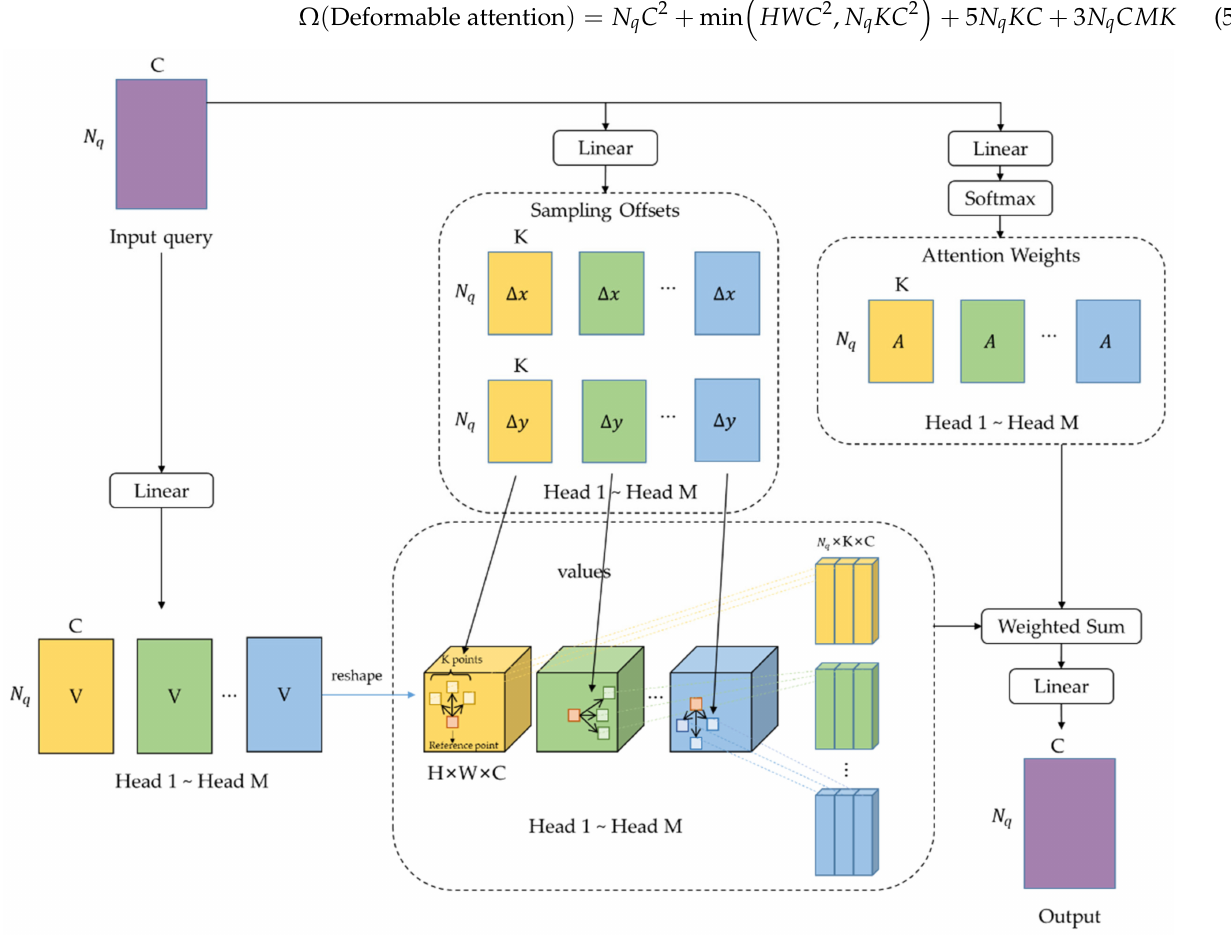
Figure 4. The calculation process of deformable attention in deformable DETR3.1.3 local parse information-